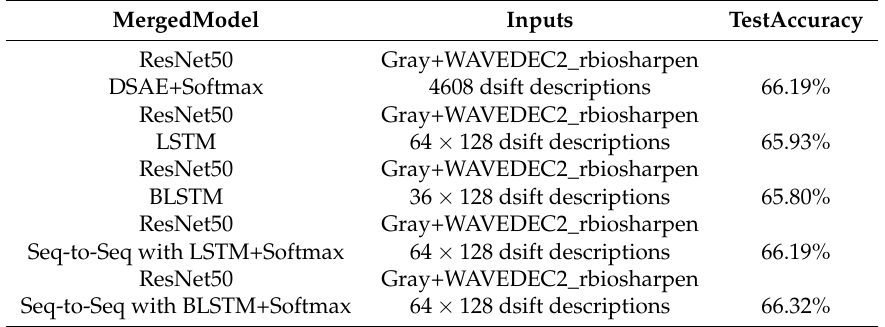
Table 8. The accuracy rates of the RAF Compound test set based on model ensembling between ResNet50 trained on spatial and frequency domain images and models trained on densesift